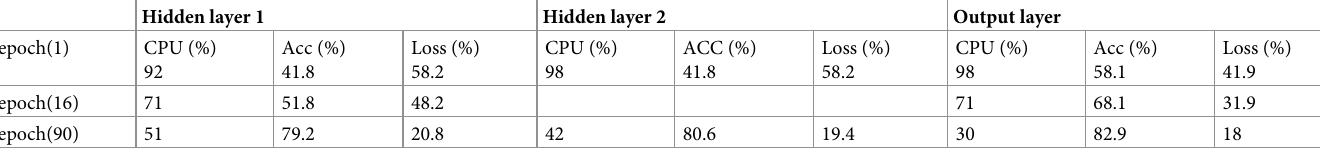
Table 7. CPU occupancy and learning metrics for the proposed model. Hidden layer